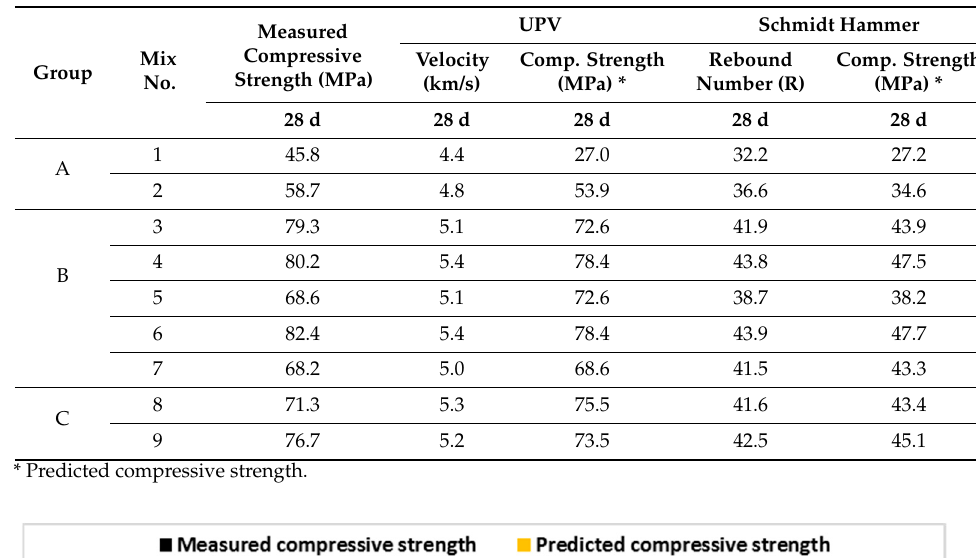
Table 6. Concrete non-destructive test results.